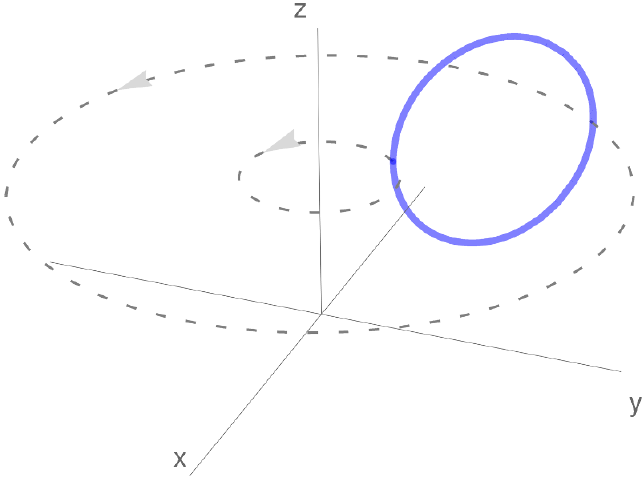
Figure 2 . The vortex ring orbit in stereographic